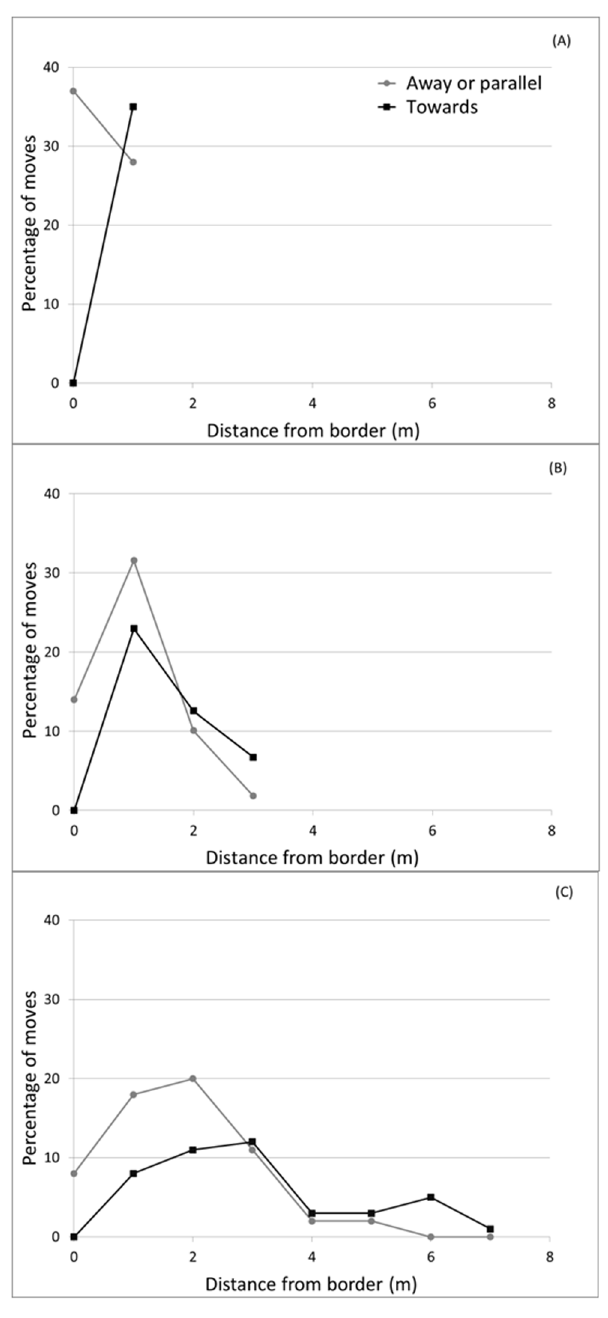
Figure 3. Walking moves away and towards potato/bare ground borders. Percentage of total moves by tracked adult Colorado potato beetles oriented away and towards bare ground borders in small (A), medium (B) and large (C) size potato plots (as described in Table 1) in 2012. The border row starts at 0 m.